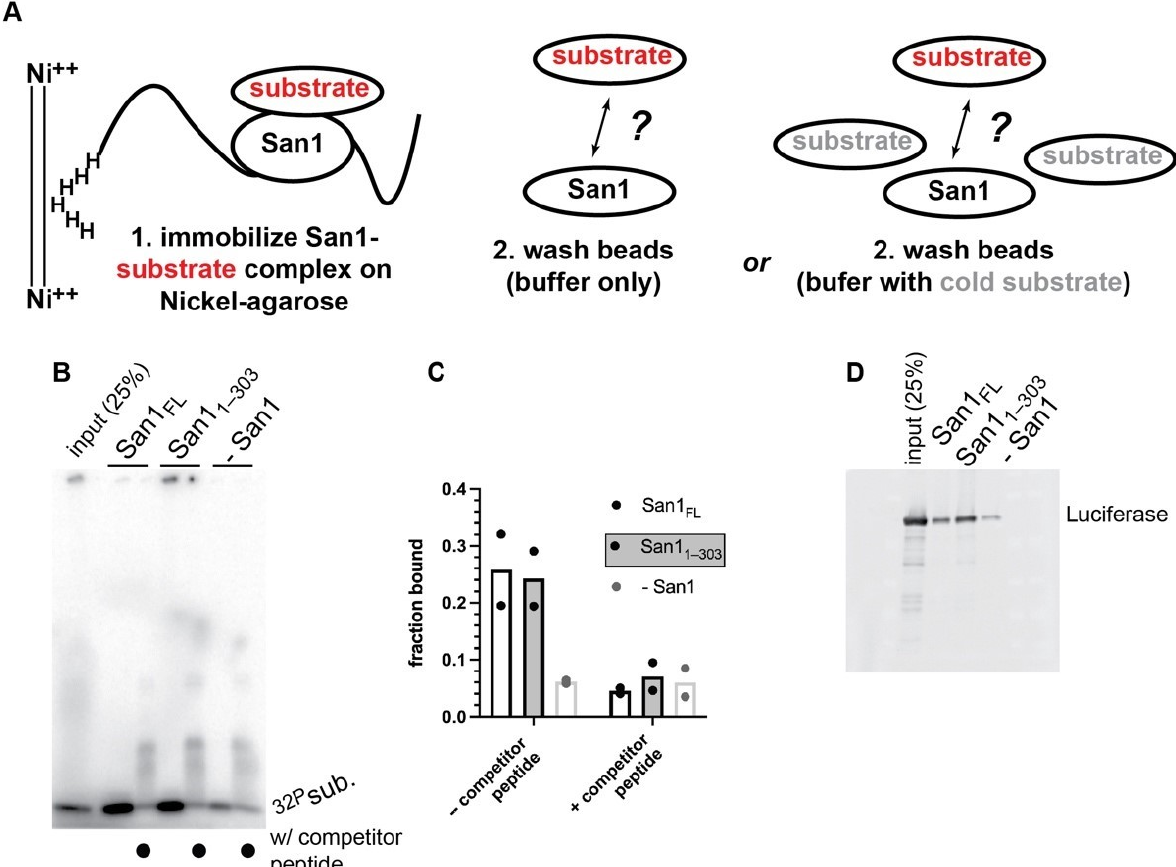
Figure 5. Peptide substrate is bound to San1 with high affinity. ( A ) Schematic showing a nickel-pulldown assay to assess the strength of the San1-peptide substrate complex. ( B ) Representative autoradiogram of the results of the nickel-pulldown assay. ( C ) Graphical representation of the results shown in panel ( B ). The results show duplicate data points from technical experimental replicates. ( D ) same as ( B ) except with heat-denatured luciferase protein